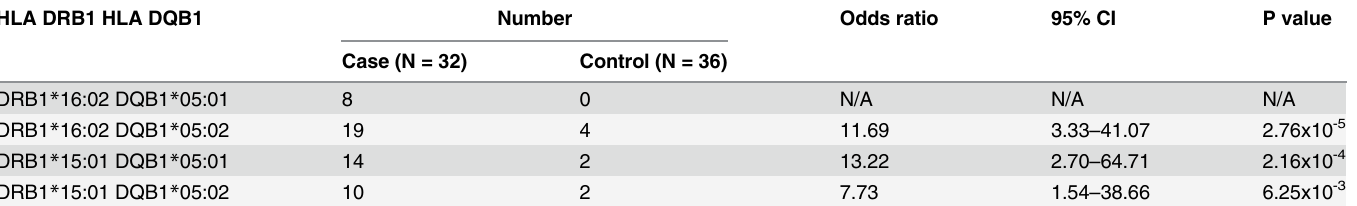
Table 5. Number of individuals who carried both HLA-DRB1 * 15:01or 16:02 and DQB1 * 05:01 or 05:02 between patients and control, and odds ratio of each haplotype. HLA DRB1 HLA